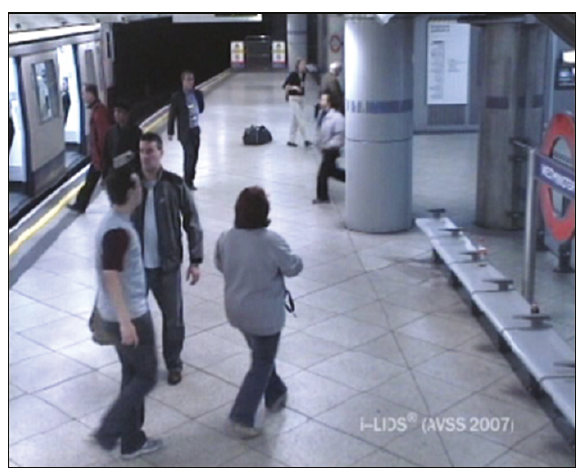
Figure 2: AVSS 2007 video dataset. Images captured via a typical surveillance camera are looking down, causing the lower part of objects to appear larger and the upper part to appear